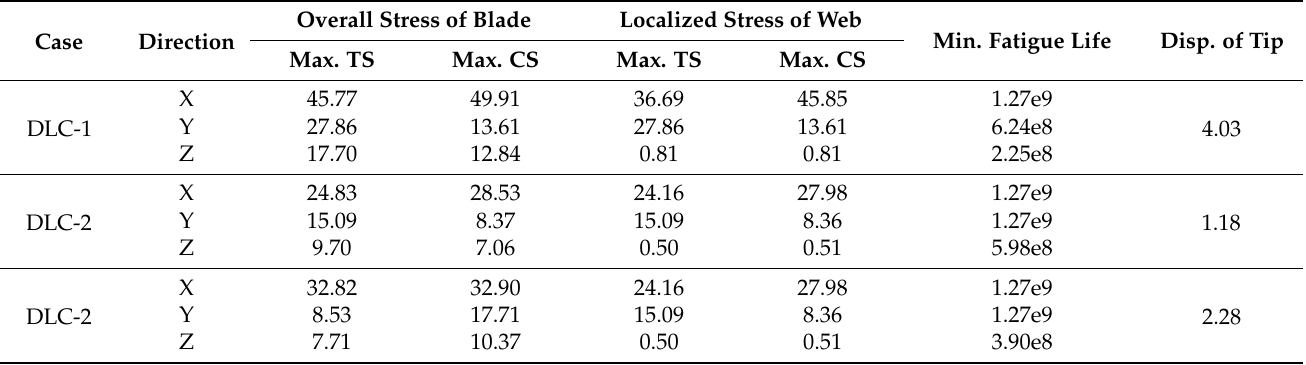
Table 7. Simulation results of the second generation wind turbine blade in the DLC-1, 2 and 3 cases. Unit in stress: MPa, in displacement of tip: